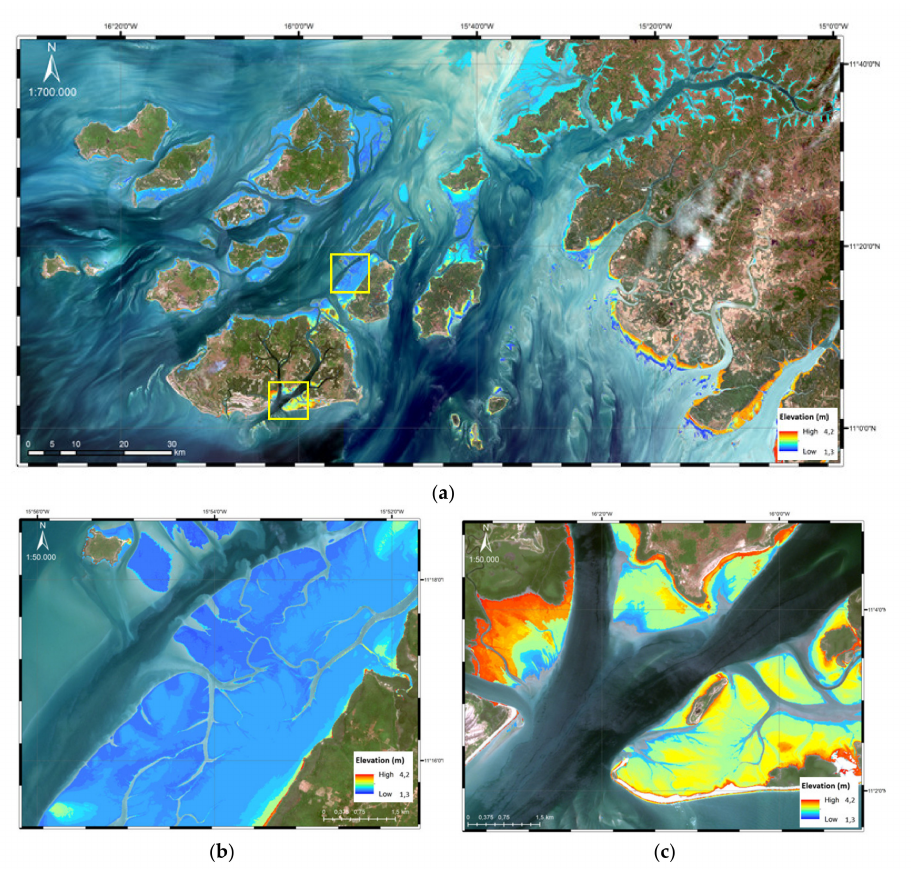
Figure 10. ( a ) Bijag ó s intertidal model estimated from 19 S2 images (red: 4.2 m and dark blue: 1.3 m). The two yellow rectangles highlight di ff erent intertidal areas; ( b ) zoom on the intertidal model estimated for the Bijag ó s (top right rectangle in ( a )—sandy beaches); and ( c ) zoom on the intertidal model (bottom left rectangle in ( a )—mostly mangroves and mudflats [37,38]).